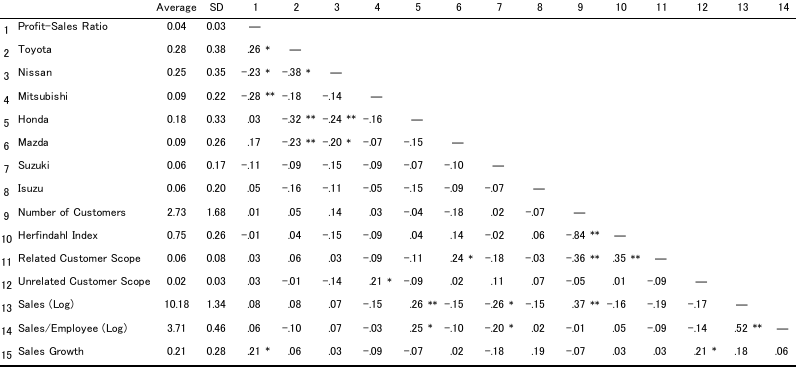
Table 3. Descriptive statistics and correlations in 2005 ( N =